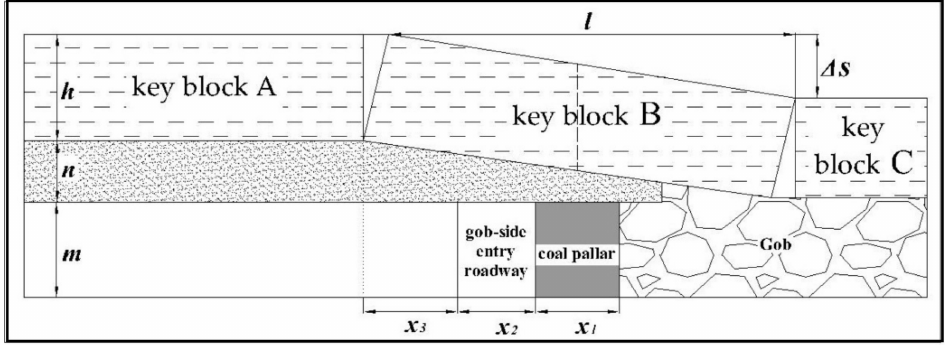
Figure 3. Mechanical model diagram of section protection coal